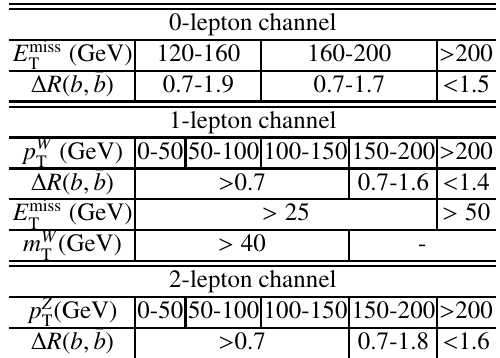
Table 2. Further topological cuts for the three channels in separate p V intervals T